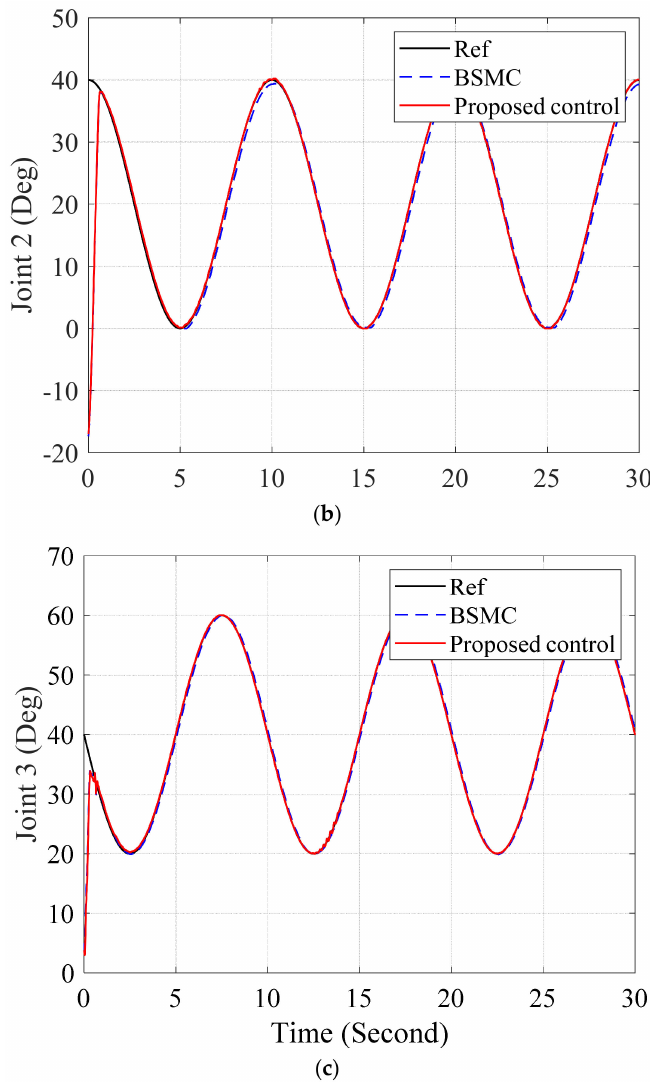
Figure 10. Joint responses of BSMC and proposed control in ( a ) joint 1, ( b ) joint 2, ( c ) joint 3 without load.